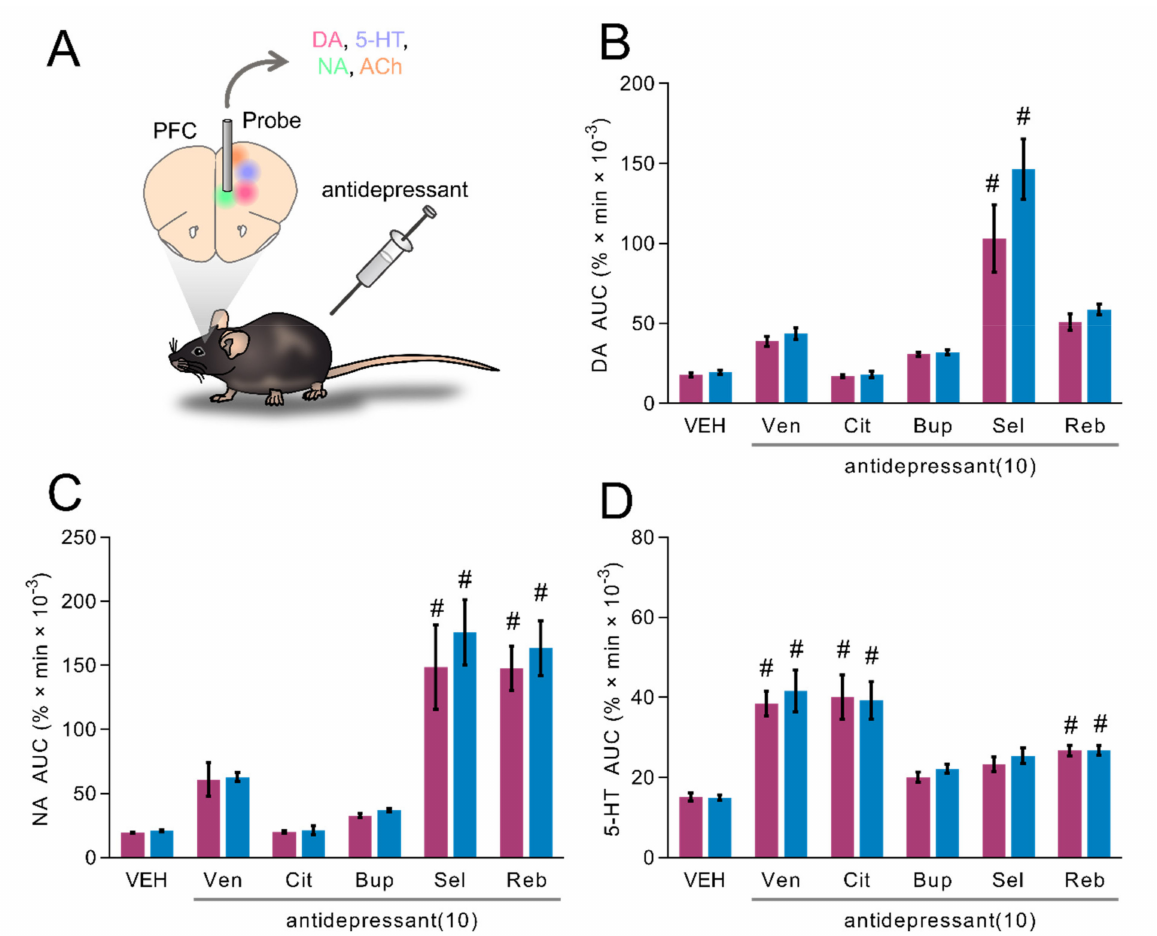
Figure 6. Effects of different antidepressants (10 mg/kg) on extracellular levels of DA, 5-HT and NA in the mPFC of TAAR1-KO and WT mice. ( A ) Schematic depiction of experimental procedure. ( B – D ) Histograms show values of areas under the curve (AUC [0 ..180] , arbitrary units) for the response of venlafaxine (Ven), citalopram (Cit), bupropion (Bup), selegiline (Sel) and reboxetine (Reb) upon DA ( A ), NA ( B ) and 5-HT ( C ). All data are means ± SEM. N = 6–8 per group. p < 0.05, vehicle + antidepressant (#). VEH: